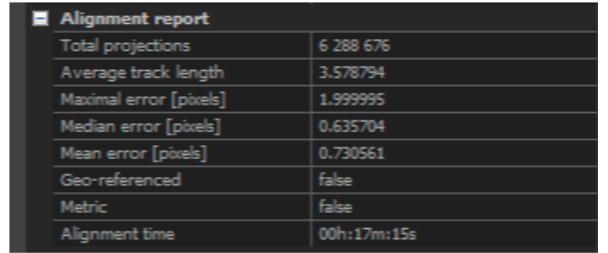
Figure A2. Screenshot of Alignment Report for Room 16 .